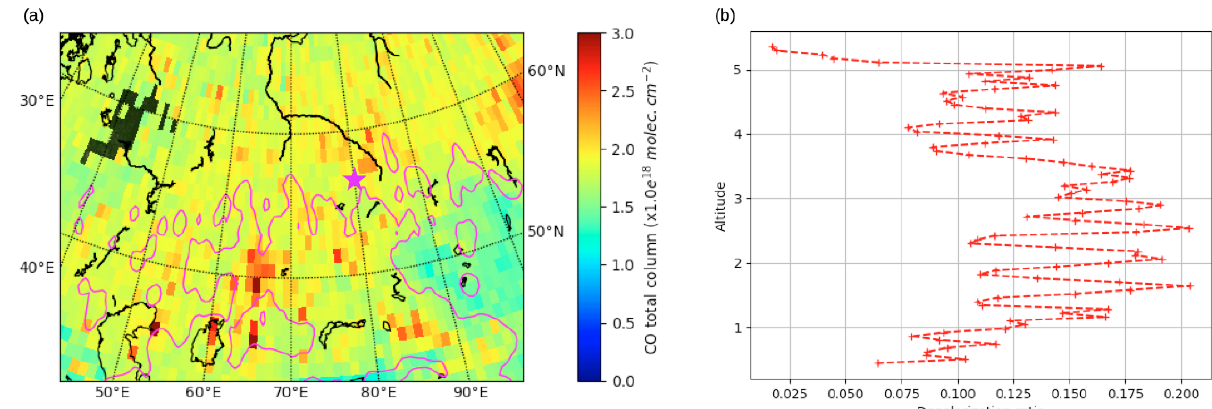
Figure 5. ( a ) Average of IASI tropospheric CO total column (in 1.0 × 10 18 molecule.cm − 2 ) from 13 to 16 June 2017. Pink isolines define areas with 10 µ m AOD > 0.08. The pink star is the aircraft position on 16 June 2017. ( b ) CALIOP 532 nm particle linear depolarization ratio vertical profile in the aerosol source region at 49.7 ◦ N, 70 ◦ E (see Figure